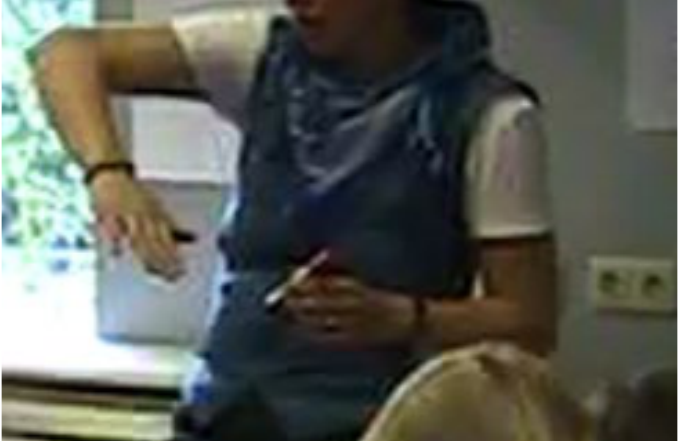
Figure 1. The figure shows an example of how Emma used gestures to support verbal reasoning. Here she makes a diagonal arm gesture when using the concept